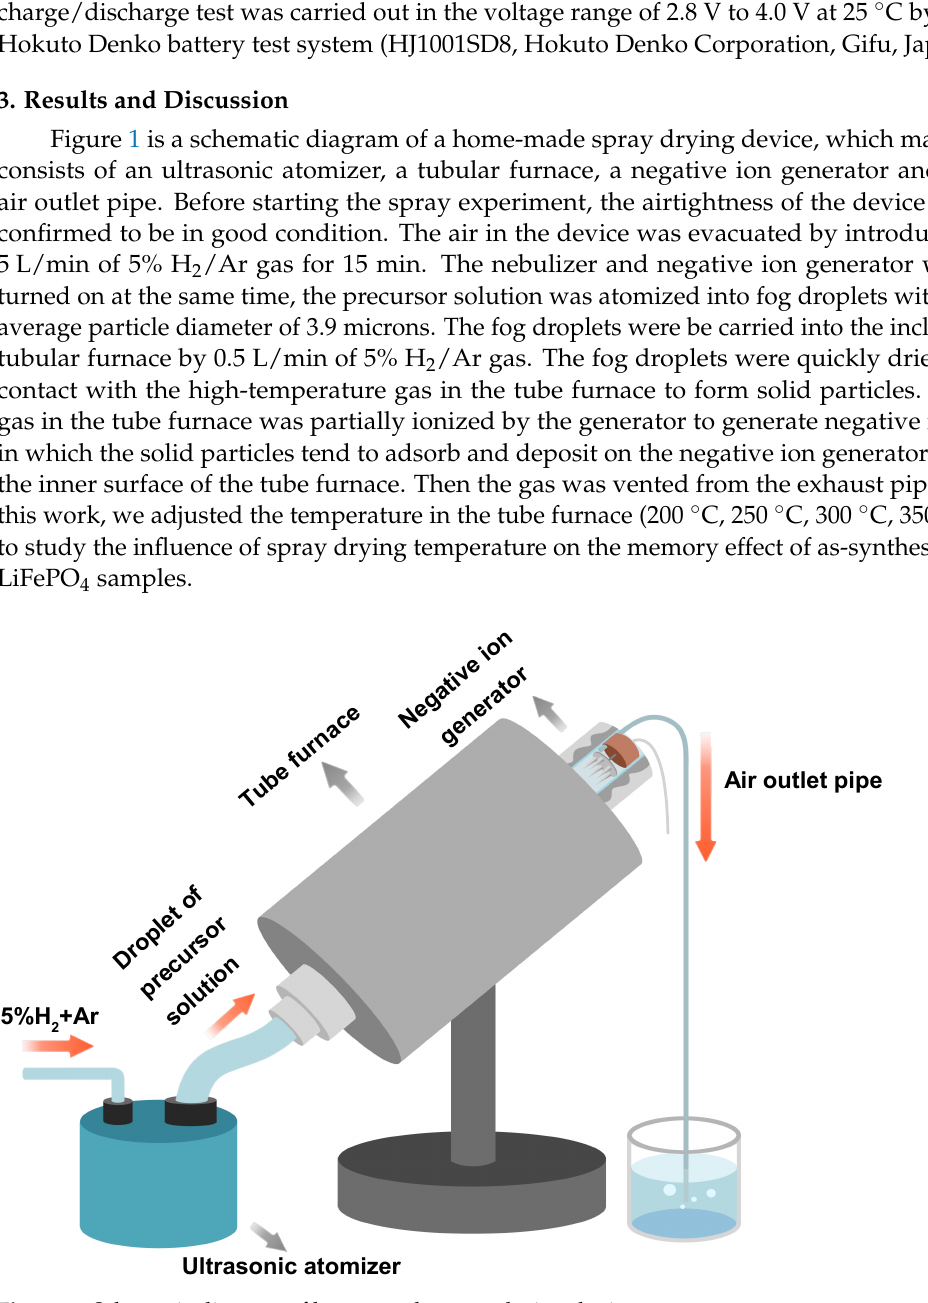
Figure 1. Schematic diagram of home-made spray drying device.